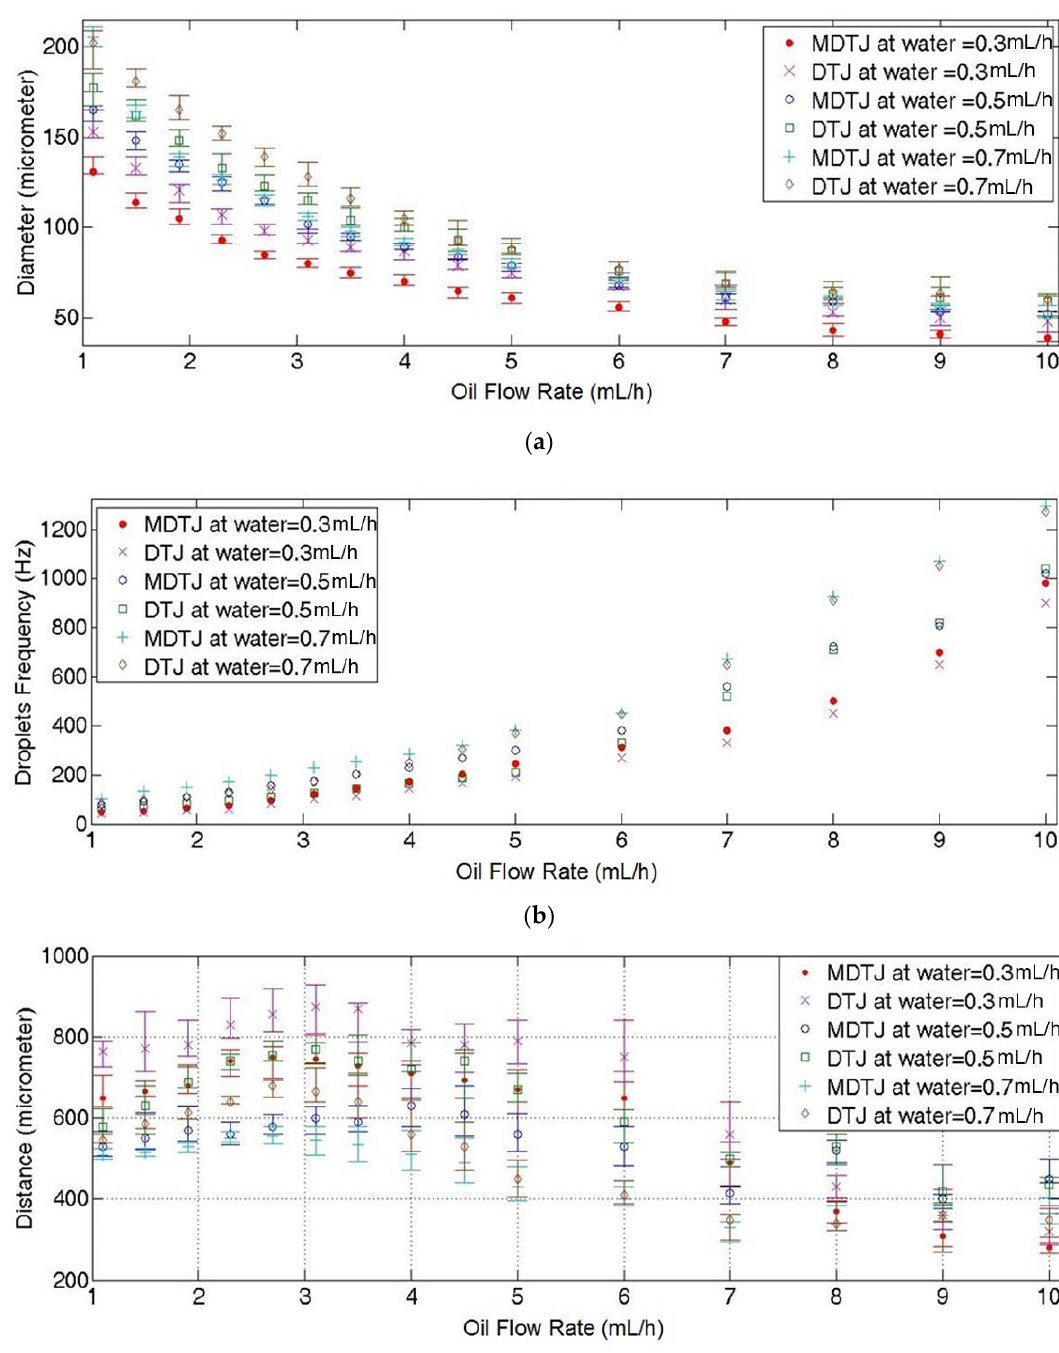
Figure 8. Illustrates three different parameters for the two channel geometries to characterize MDTJ channel. These results were measured at different oil flow rate ranging from 1.1 to 10 mL/h at water flow rates of 0.3 mL/h, 0.5 mL/h and 0.7 mL/h, as follows: ( a ) Droplet diameter which was measured from 19 readings. ( b ) Droplet frequency which was manually counted from high speed microscope video. ( c ) Distance between droplets inside the two channels which was measured from 17 readings. Error bar in ( a ) represents the variation of droplets size and in ( c ) represents the variation of interspacing distance between droplets.